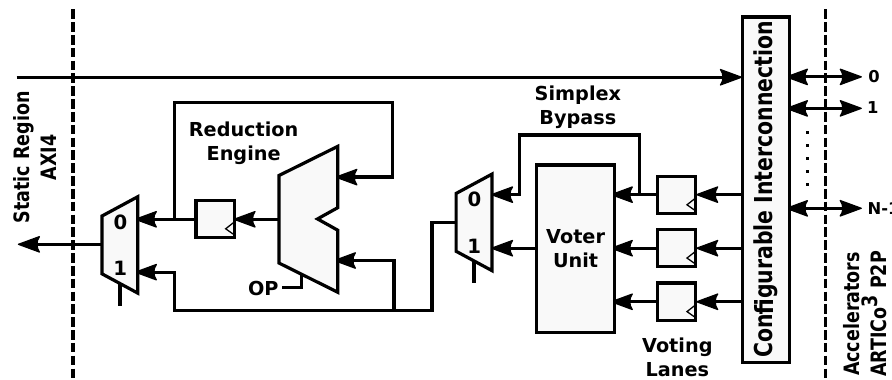
Figure 3. ARTICo 3 datapath. Its configurable structure allows dynamic changes to support fault-tolerant operation using the voter unit, parallel execution using the Simplex bypass, and data reduction using the configurable reduction